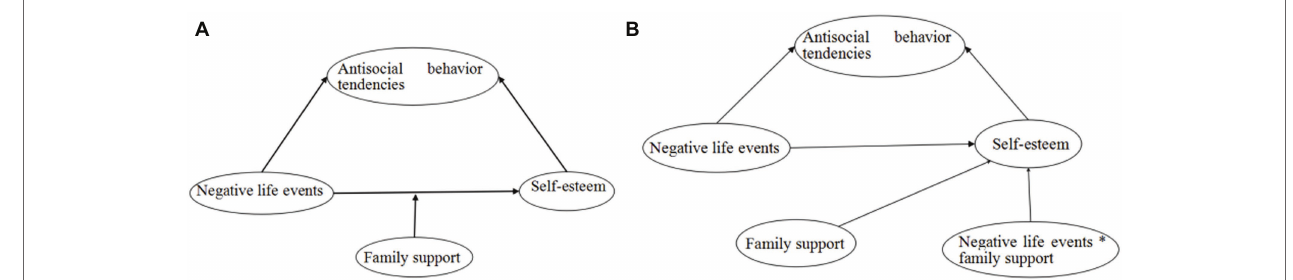
FIGURE 1 | The theoretical hypothesis model of the present study ( A : model diagram; B : statistical